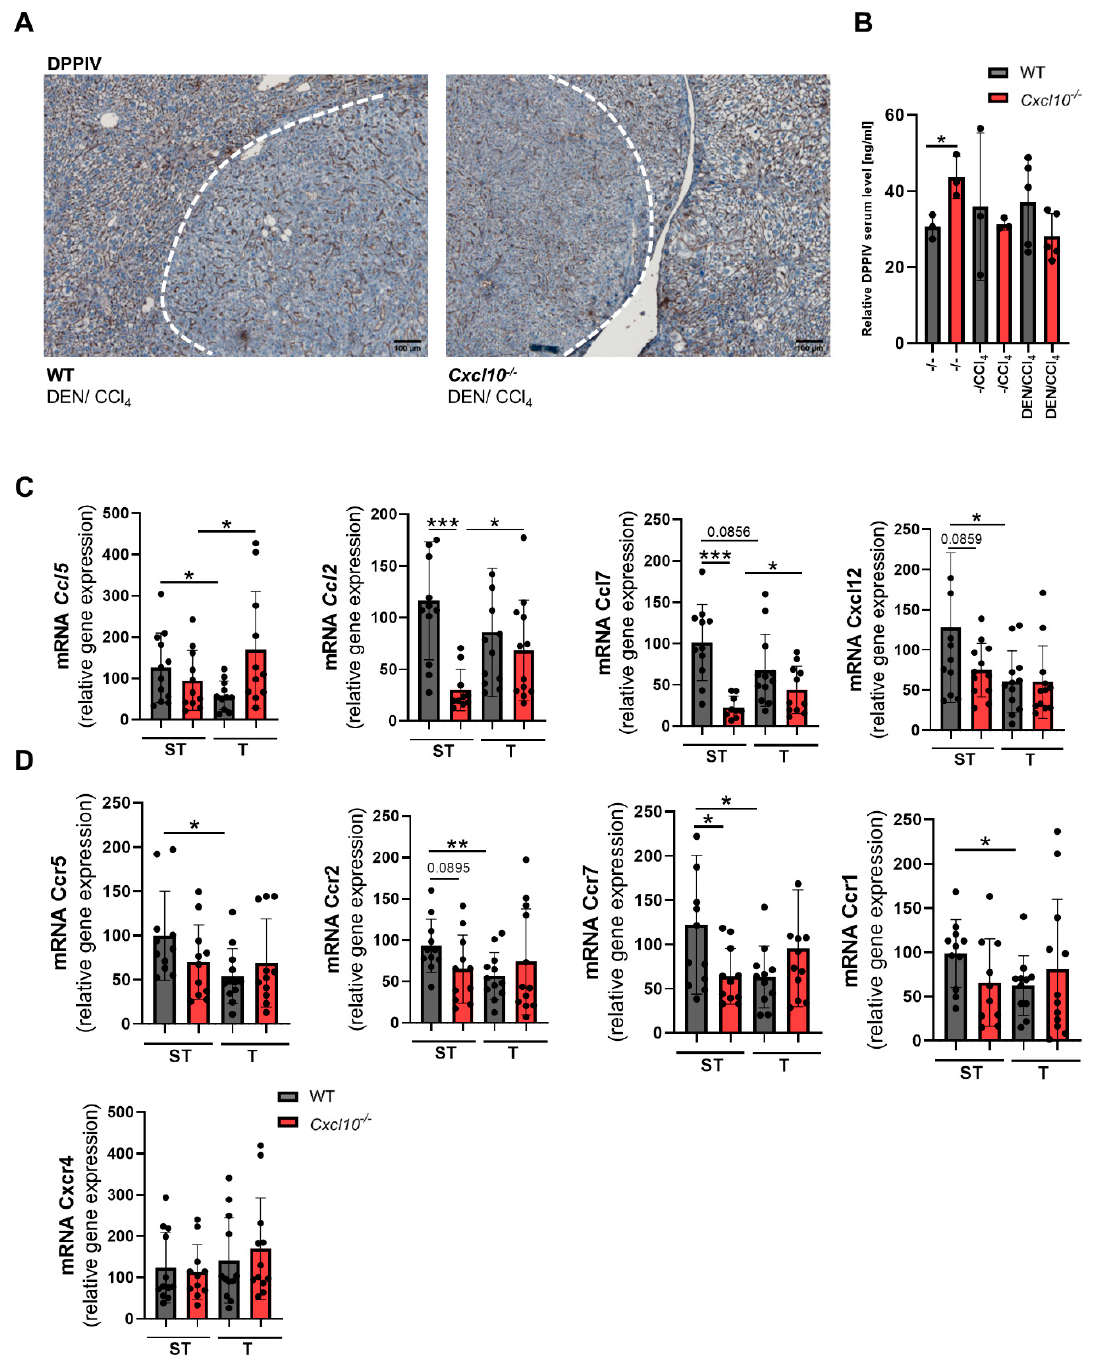
Figure 7. Genetic deletion of Cxcl10 contributes to a rearrangement of the chemokine/chemokine receptor network: ( A ) immunohistological staining of DPPIV of the DEN/CCl4-treated WT animals and Cxcl10 − / − animals (scale bar 100 µ m); ( B ) quantification of serum DPPIV via ELISA of all experi- mental groups (n ≥ 3); ( C , D ) characterization of the inflammatory chemokine/ chemokine receptor network via qRT-PCR; mRNA expression level of Ccl5 , Ccl2 , Ccl7 Ccr5 , Ccr2 , Ccr7 , Ccr1 and Cxcr4 . The mRNA expression was normalized to the expression of 18S . Data are expressed as mean ± SEM. Asterisks indicate statistical significance: * p < 0.05, ** p < 0.01, *** p < 0.001